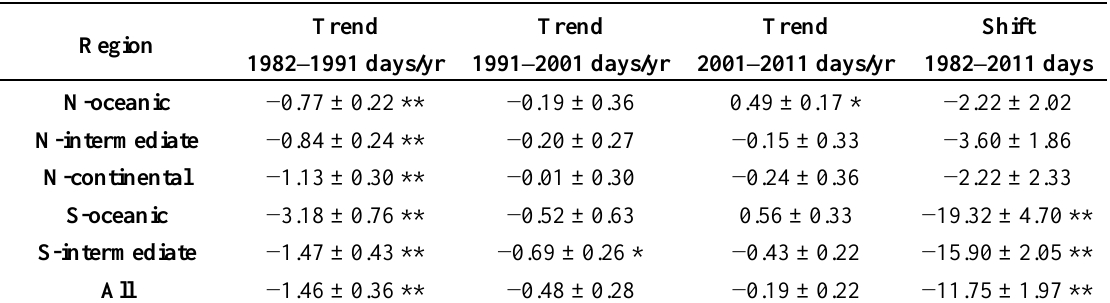
Table 1. Linear trends (days/year) for the NDVI-based start of the growing season for the three decadal time periods (1982–1991, 1991–2001, 2001–2011) and the total number of days shifted in the start of the growing season for the whole 1982–2011 time period for the various regions. * = p < 0.05; ** = p < 0.01.